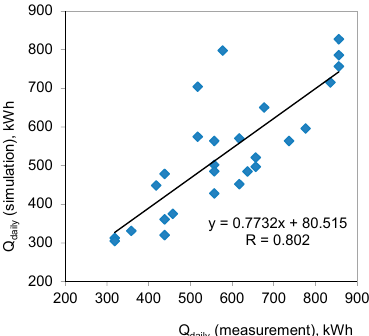
Figure 3. Correlation of the measured and simulated daily heat demand in the validated period for the residential building.